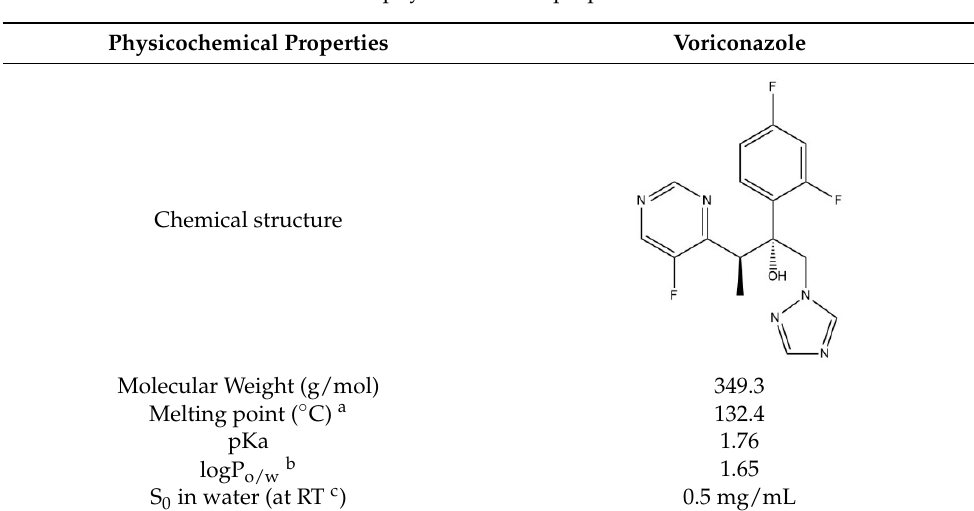
Table 1. Chemical structure and some physicochemical properties of voriconazole.